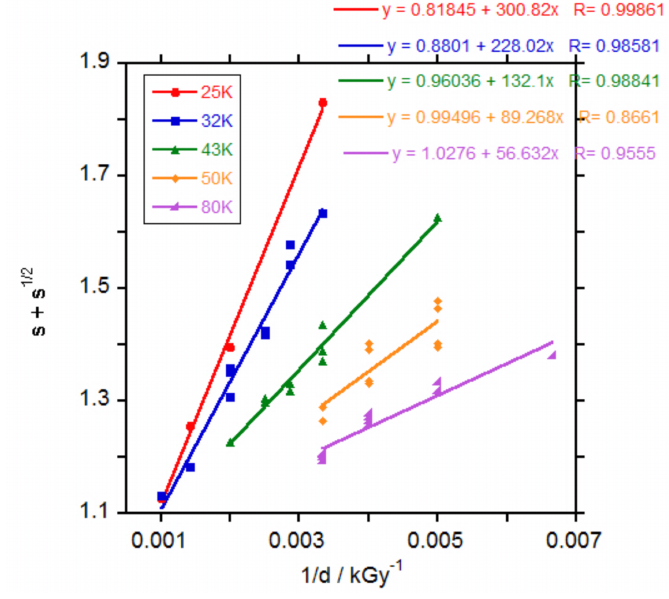
Figure 2. Charlesby-Pinner plot of irradiated